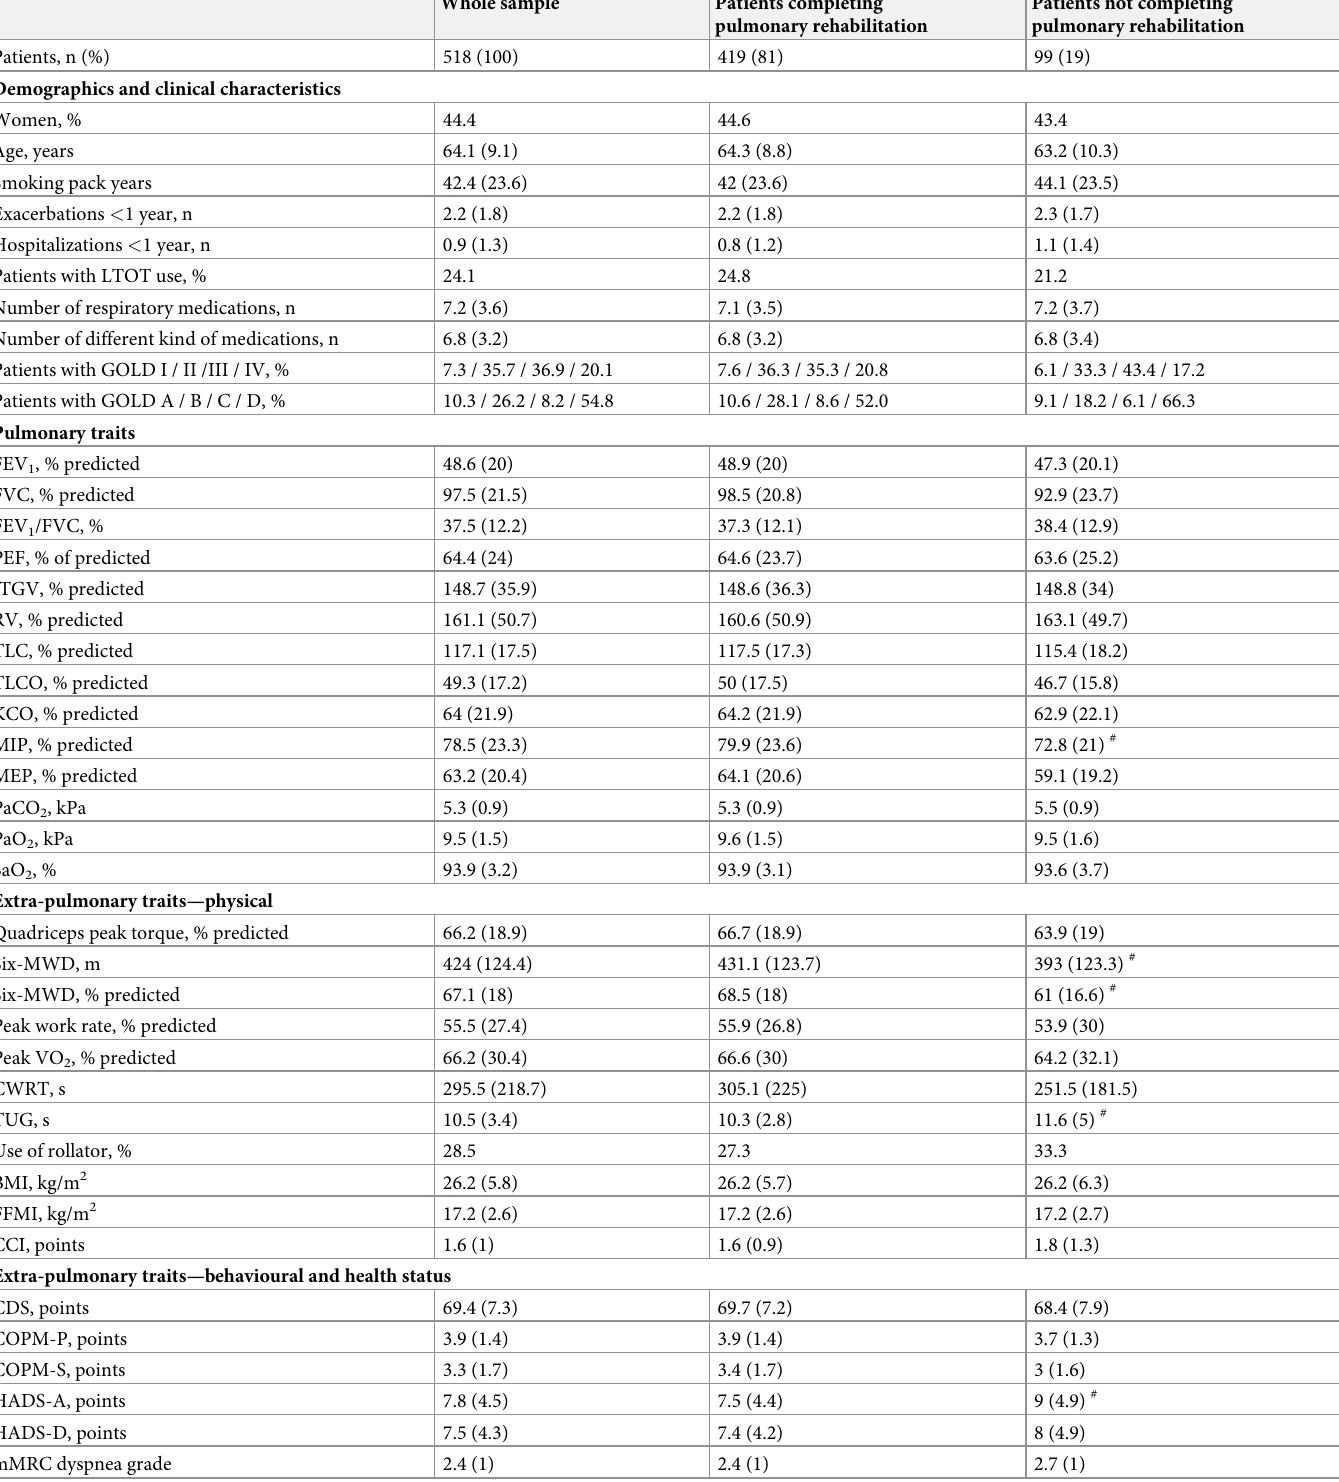
Table 1. Demographics, clinical characteristics, pulmonary, extra-pulmonary, behavioral and health status of the whole sample, patients completing and not com- pleting pulmonary rehabilitation. Whole